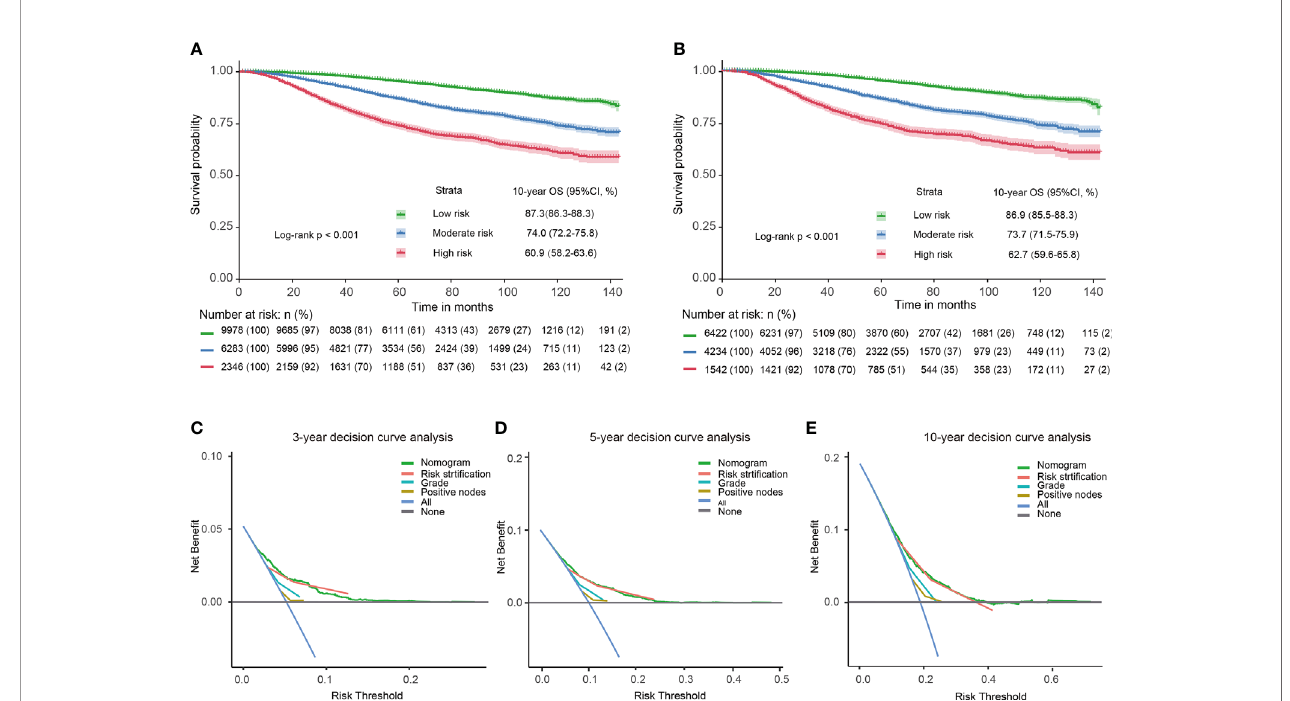
FIGURE 3 | Kaplan-Meier survival curves and decision curves for T1 – 2 breast cancer with 1 – 3 positive lymph nodes. Survival curves in the entire cohort before PSM (A) and after PSM (B) strati fi ed by the total score of the nomogram. 3-year (C) , 5-year (D) , 10-year (E) decision curves show that nomogram and its risk strati fi cation have the highest net bene fi t almost across the entire threshold probabilities. Blue line: net bene fi t of a strategy of treating all T1 – 2 breast cancer with 1 – 3 positive lymph nodes. Gray line: net bene fi t of treating no patients of T1 – 2 breast cancer with 1 – 3 positive lymph nodes. Colored lines: net bene fi t of a strategy of treating patients according to the nomogram, risk strati fi cation, grade, and positive